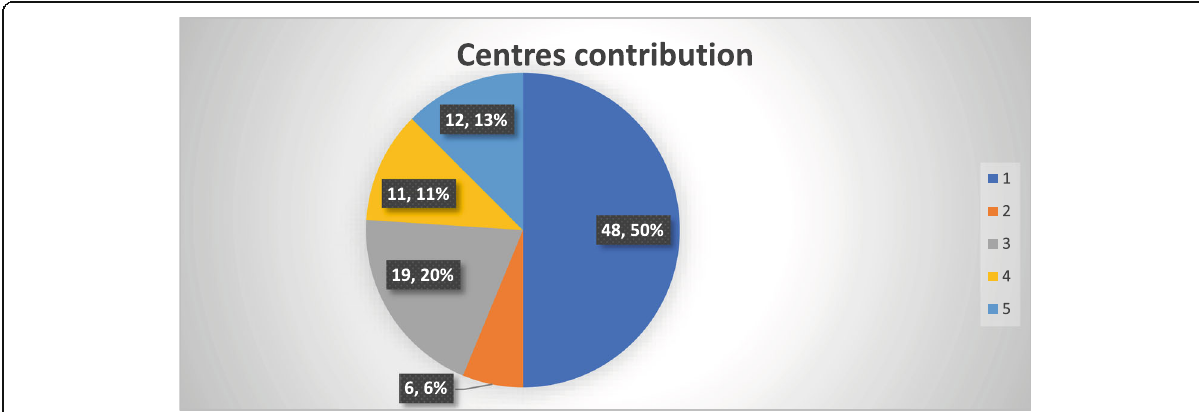
Fig. 1 Centers contribution. (1) Aswan Heart Centre, Magdi Yacoub Foundation; (2) Galaa Military Hospital Magdi Yacoub Foundation Unit; (3) Ain Shams University Hospital; (4) Dar El fouad, October city; and (5) Andalusia Hospital